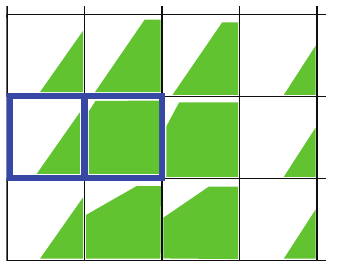
Figure 13: Possible regions of interest.